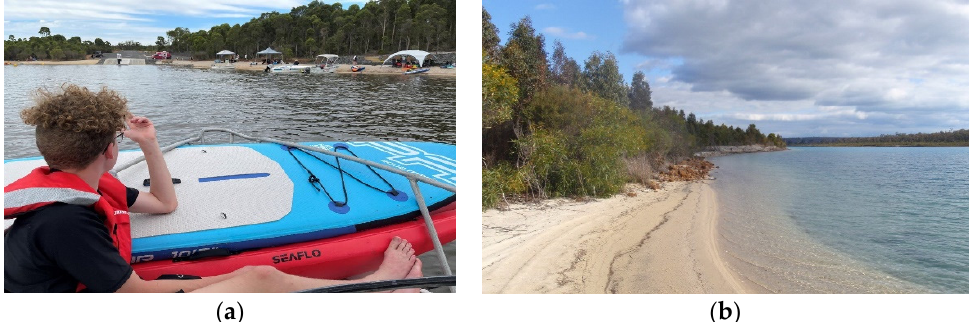
Figure 3. ( a ) Lake Kepwari in 2009; ( b ) locals and tourists recreating at Lake Kepwari soon after it opened in summer 2021 [3].